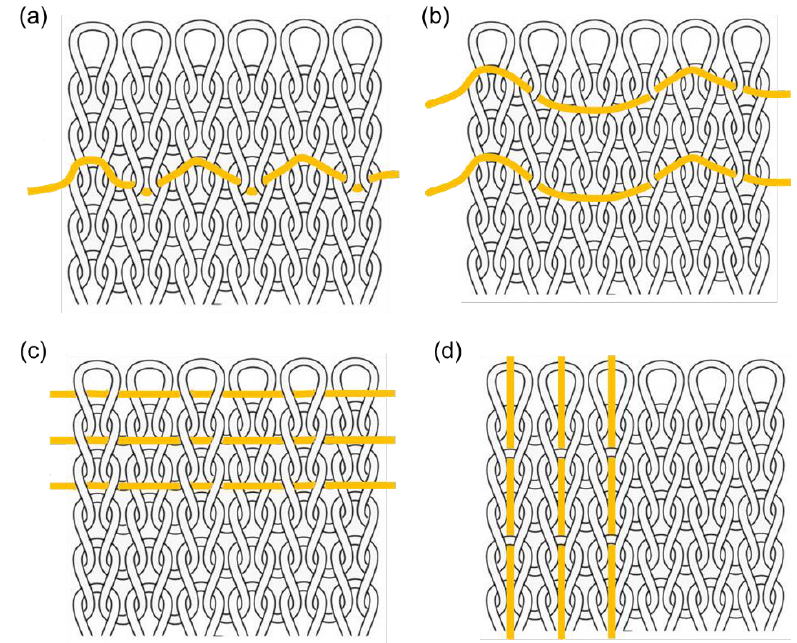
Figure 11. Optical fiber laid-in weft knitting designs: ( a ) single jersey hopsack structure; ( b , c ) other weft laid-in structures; ( d ) warp laid-in structure.